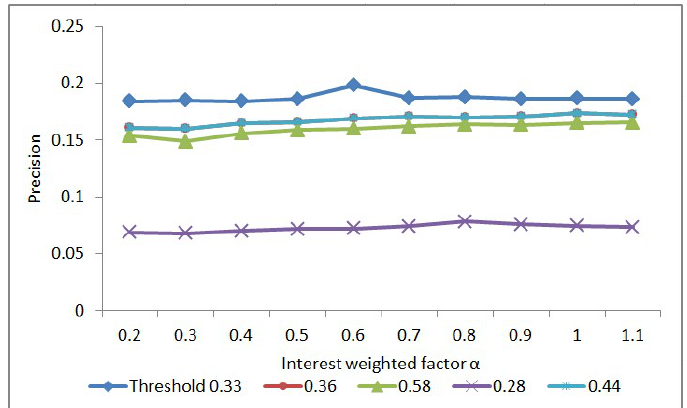
Figure 10. Precision with thresholds and interest weighted factors.